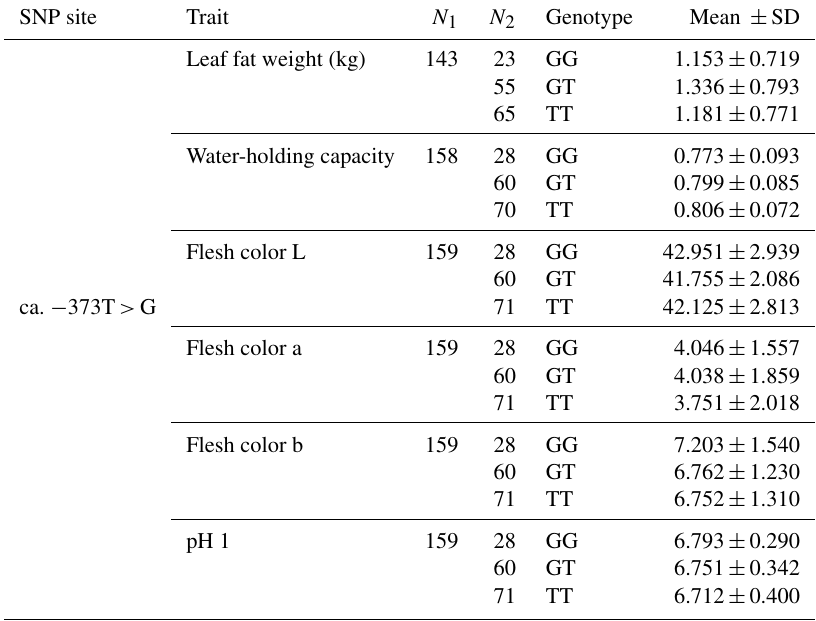
Table 4. Muscle traits of different genotypes at ca. − 373T > G in UBXN1